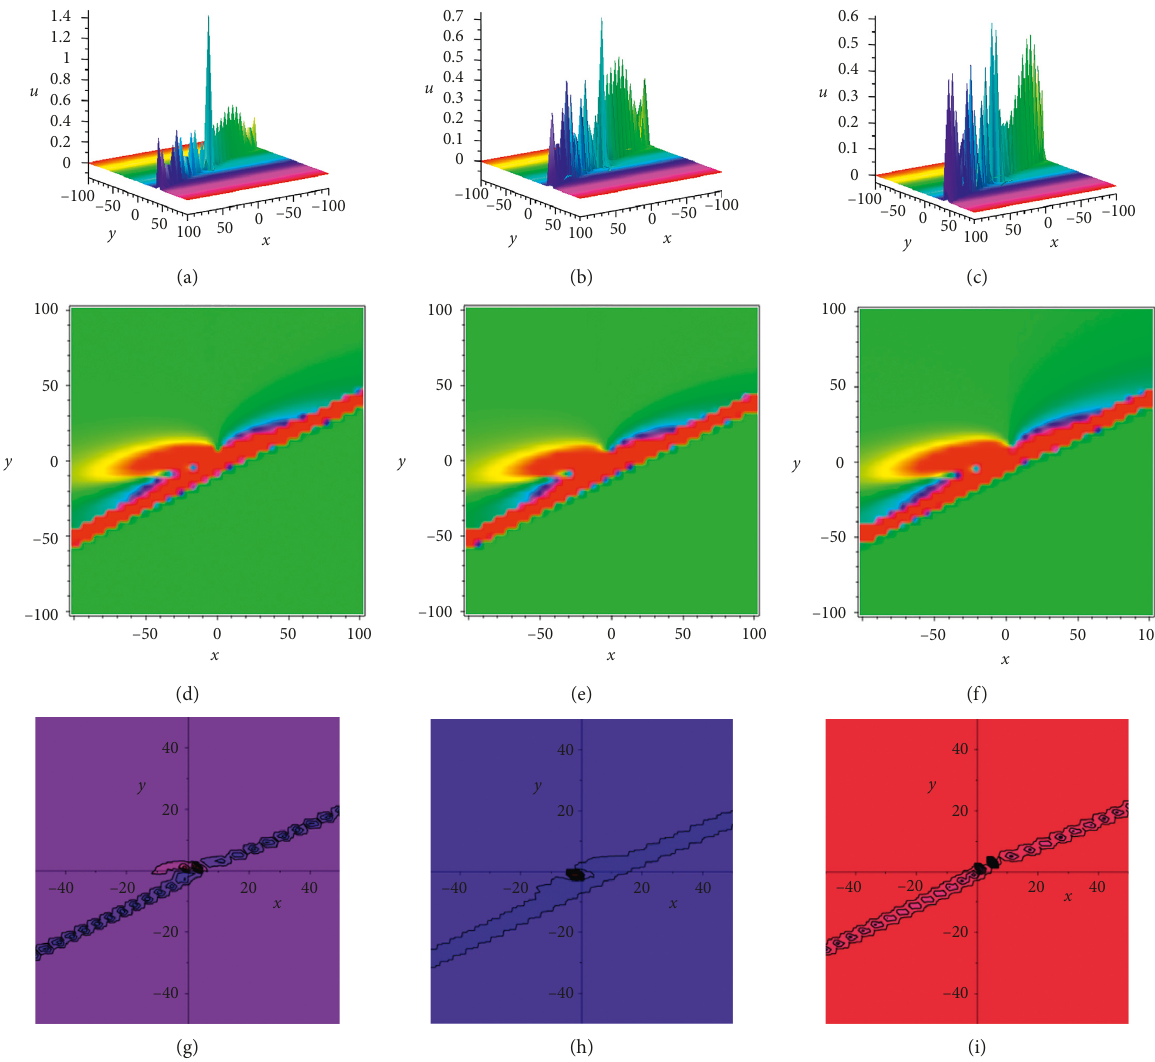
Figure 2: 3D plots, density plots, and contour plots of lump wave solution (20) with the specific parameters � 1 , b � 1 ,b � 1 ,b � 1 , c [ 1 ] � 1 , α � 1 , and β � 2. (a), (d), and (g) are for t � − 5; (b), (e), and (h) are for t � 0; (c), (f), and (i) are k � 1 , a 4 1 3 4 for t �